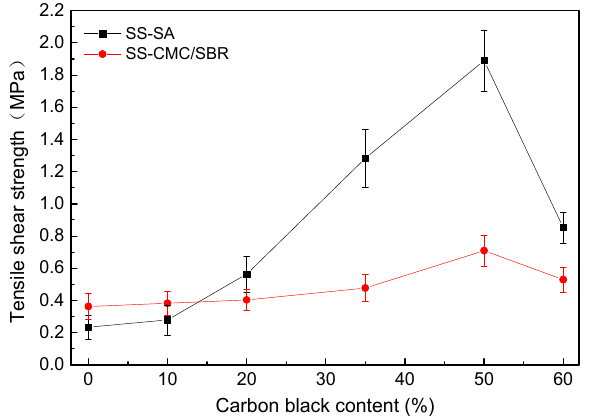
Figure 6. E ff ect of carbon black (SS) content on tensile shear strength of BCC with various Figure 6. Effect of carbon black (SS) content on tensile shear strength of BCC with various aqueous aqueous polymers.